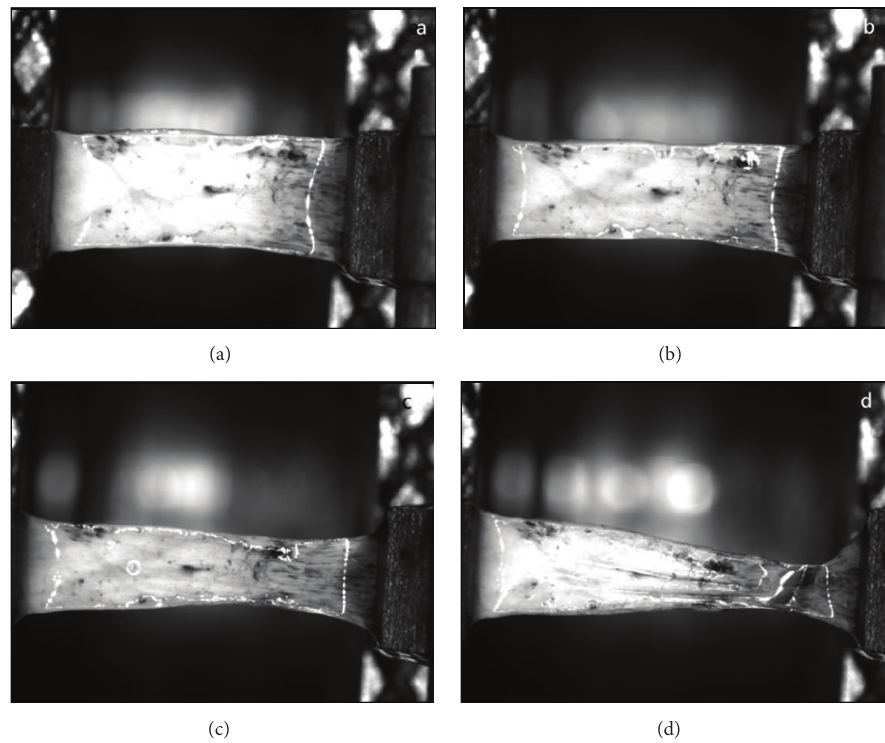
Figure 2: Stress-strain measurement of the scleral strip. ((a)–(d)) Showing that together with increased stress, the strain in the sclera strip increased. In (d) the strip is almost